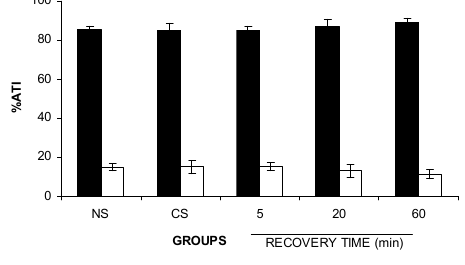
Figure 6. ATI% in the soluble and insoluble fractions of the blood cells from Wistar rats after recovery from the forced swimming (FS). Wistar rats were submitted to FS for 2.5 min and recovery was followed for different periods of time. After that, blood samples were withdrawn and the labeling of blood constituents with the 99m Tc procedure was carried out. Blood cells were separated by centrifugation and insoluble and soluble fractions of blood cells were isolated by precipitation in trichloroacetic acid centrifugation. The radioactivity in each fraction was measured and the percentage of 99m Tc incorporated (%ATI) was calculated.